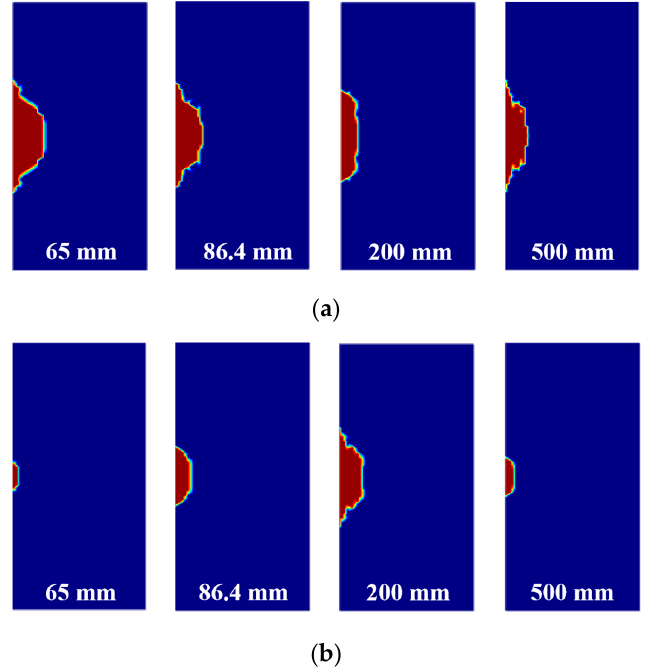
Figure 8. Distribution of the plastic zone and waveguide aperture under the irradiation time of 60 s. ( a ) Irradiation distance of 5 cm; ( b ) irradiation distance of 8 cm. ( a ) Irradiation distance of 5 cm; ( b ) irradiation distance of 8